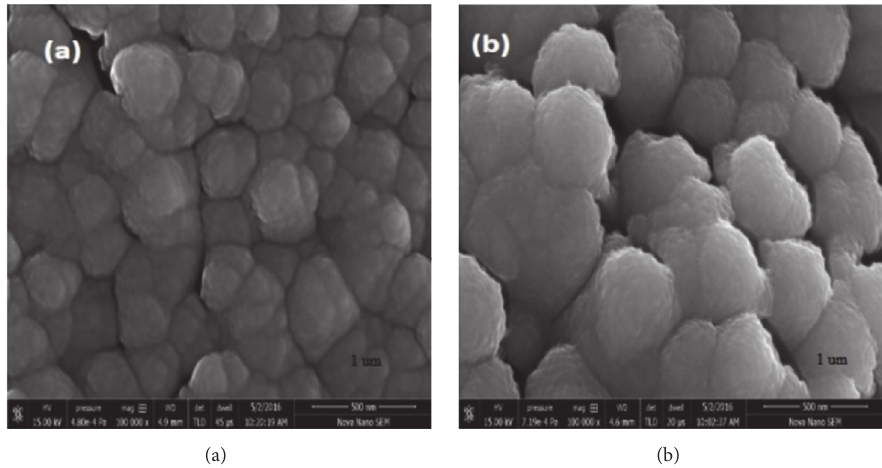
Figure 4: SEM images: (a) without annealing and (b) with